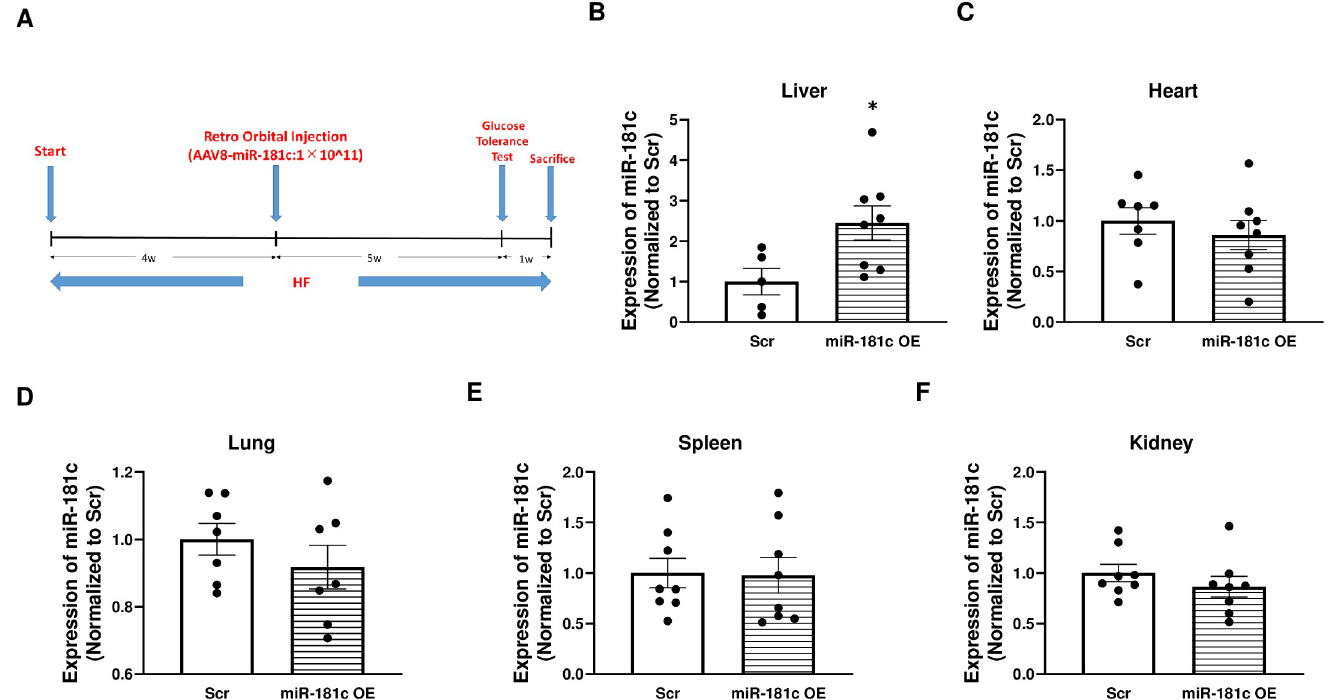
Fig 7. Liver-specific miR-181c delivery and validation. (A) In vivo miR-181c overexpression protocol. Quantitative polymerase chain reaction (qRT-PCR) analysis of miR-181c expression in total RNA isolated from liver (B) , heart (C) , lung (D) , spleen (E), and kidney (F) . OE, overexpression; Scr, scrambled oligonucleotide. Data are expressed as mean ± SEM; n = 8 for panels B-F. � p < 0.05 by t-test analysis. � p < 0.05 by two-sample t-test.